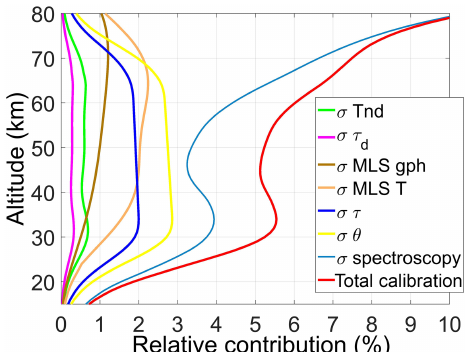
Figure 9. Relative contributions to the calibration uncertainty de- fined by Eq. (28) and indicated with a red solid curve. The contri- butions are the signal beam angle (yellow), the noise diode tempera- ture (green), the sky opacity (blue), the MLS meteorological profiles (orange and brown), the compensating sheet opacity (magenta), and the spectroscopic parameters